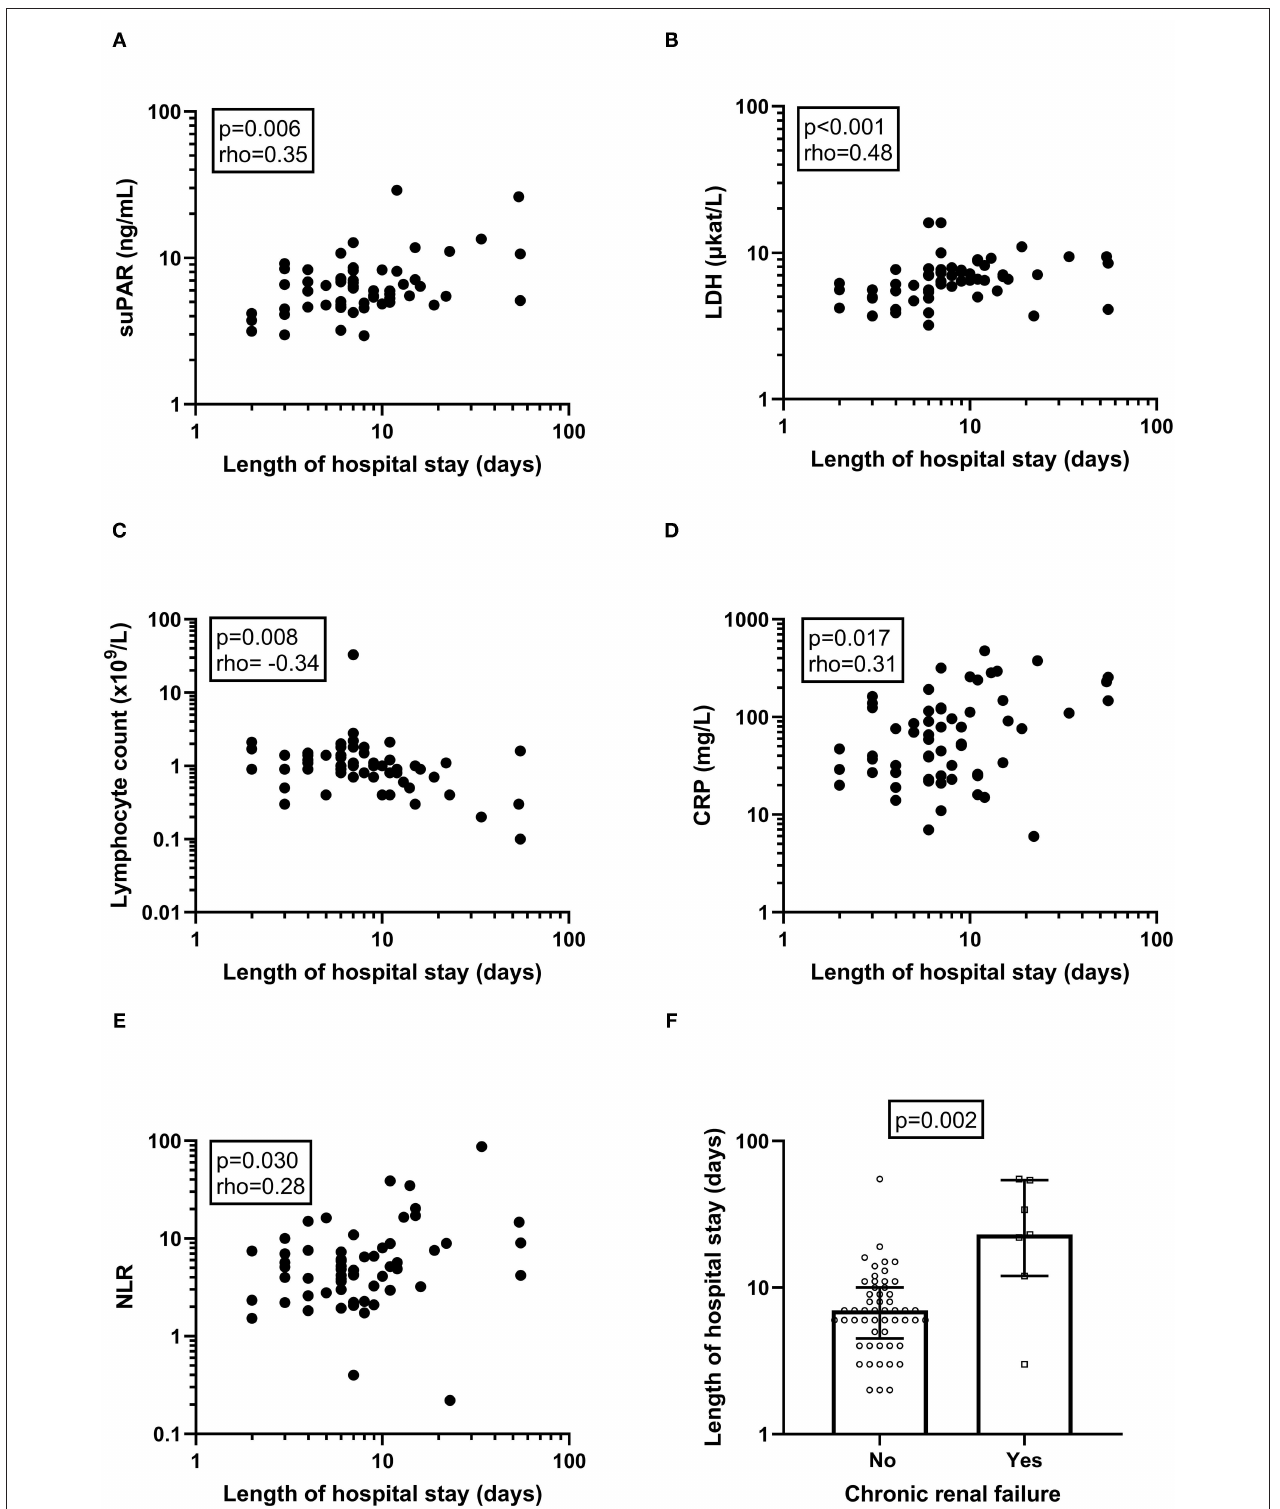
FIGURE 2 | Correlations and associations of biochemical and clinical variables with length of hospital stay. The correlation between the length of the hospital stay and biochemical (A–E) and clinical variables (F) were examined. Deceased patients ( n = 2) were given a fictive length of stay of 55 days to avoid bias. P -value and Spearman’s correlation coefficient (rho) is given for each correlation analysis. P -value from Mann-Whitney U -test is given for CFR. Please observe that axes display a logarithmic scale. suPAR, soluble urokinase plasminogen activator receptor; LDH, lactate dehydrogenase; CRP, C-reactive protein; NLR, neutrophil-to-lymphocyte